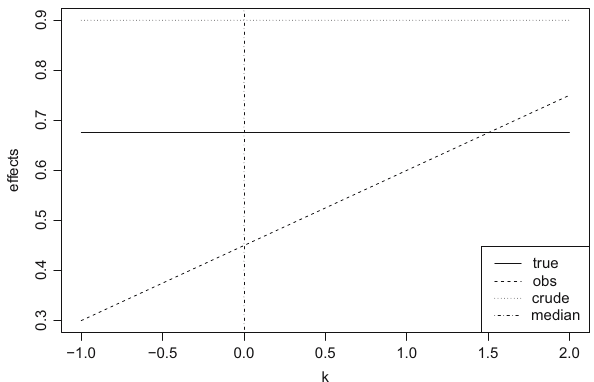
Figure 4: True, observed, and crude e ff ects as functions of the cuto ff k in Setting